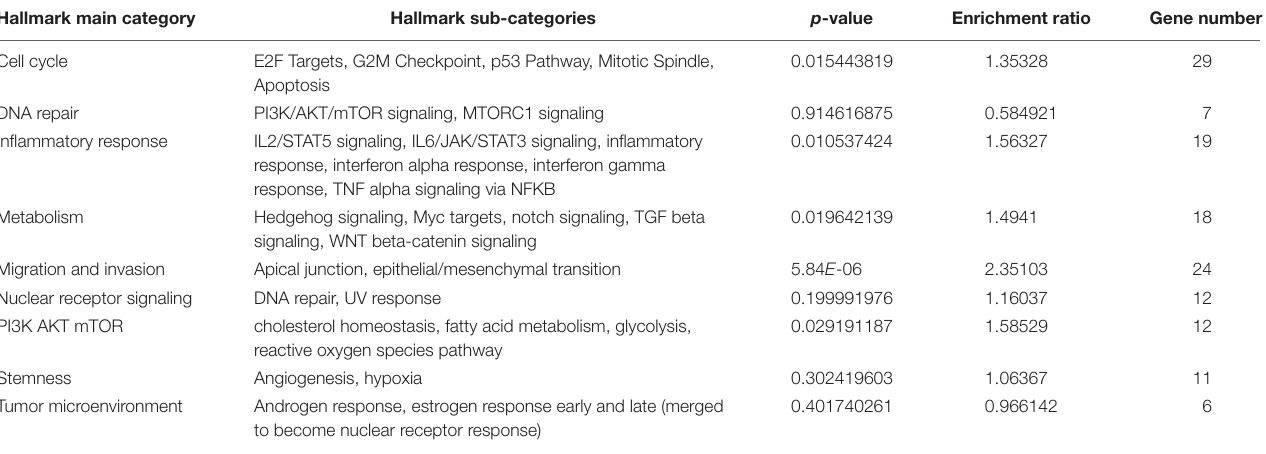
TABLE 2 | Cancer hallmark pathway enrichment result of all proteins involved in the TieDIE sub-network. Hallmark main